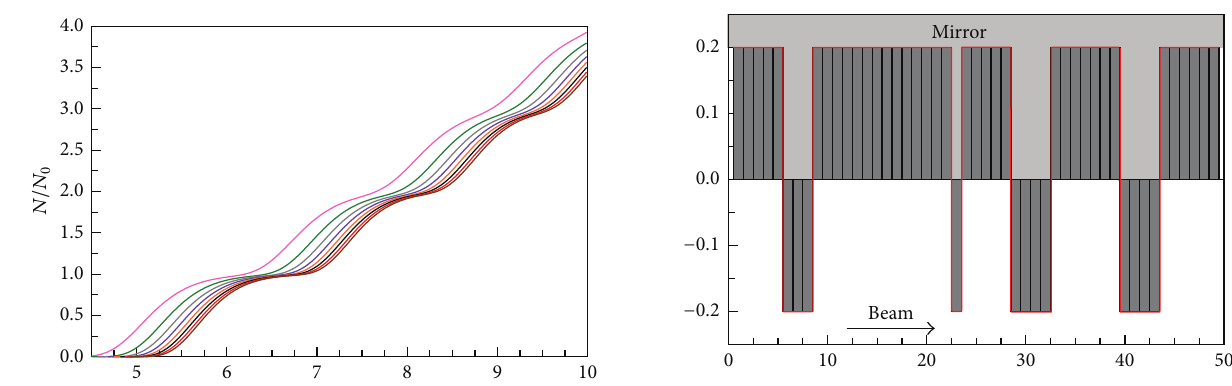
Figure 5: A fragment of the proposed rough upper mirror based on Monte Carlo simulations ( 10 6 cycles) for the 1D Ising model with 𝐽/𝑘𝑇 ≈ 0.7 . Thick red line is the surface profile and dark bars are the “Ising spins.” Mirror material is above the red line (the filled area). The amplitude of roughness 𝜂 = 0.2 , the correlation radius ≈ 43.5 . Both axes are in units of 𝑟 = 2 , and the value of Φ 1 𝑙 = ℏ 2/3 (2𝑚 2 𝑔) −1/3 ∼ 5.871 𝜇 m. The vertical scale is about 100 0 times smaller than the horizontal one. The value of 𝜂 can be changed simply by rescaling the vertical